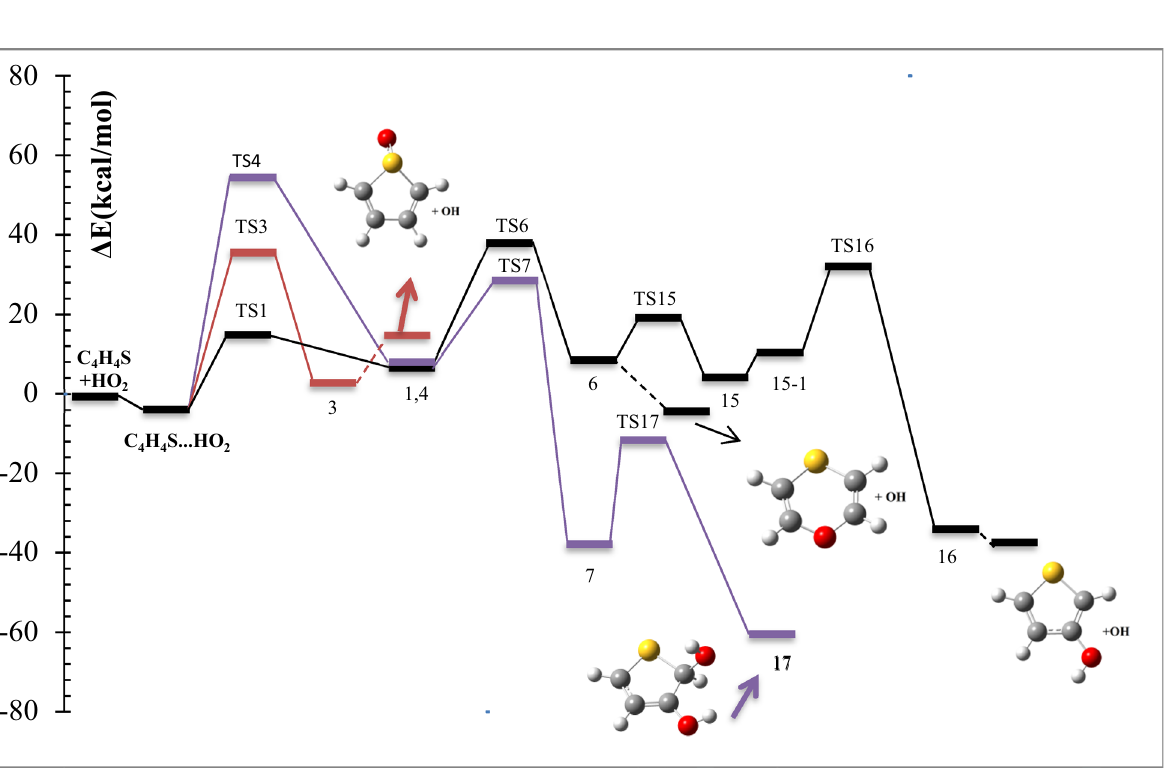
Figure 4. Potential energy profile of the thiophene + HO 2 reaction including the addition of middle oxygen of HO 2 radical to β-C (purple) and sulfur (red) atoms, and reactions of obtained products drawn at the BD(T)/6- 31 + g(d,p)